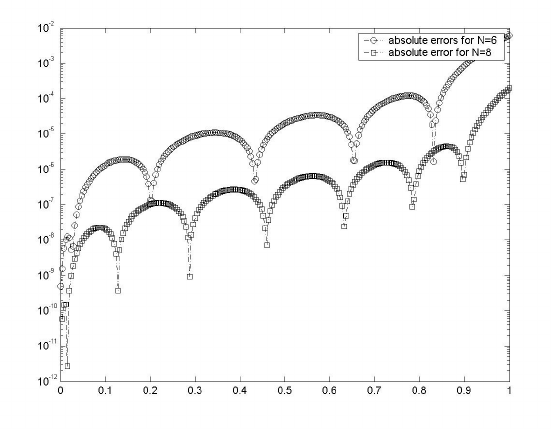
Fig. 1: Comparison of absolute errors function for y 1 ( t )